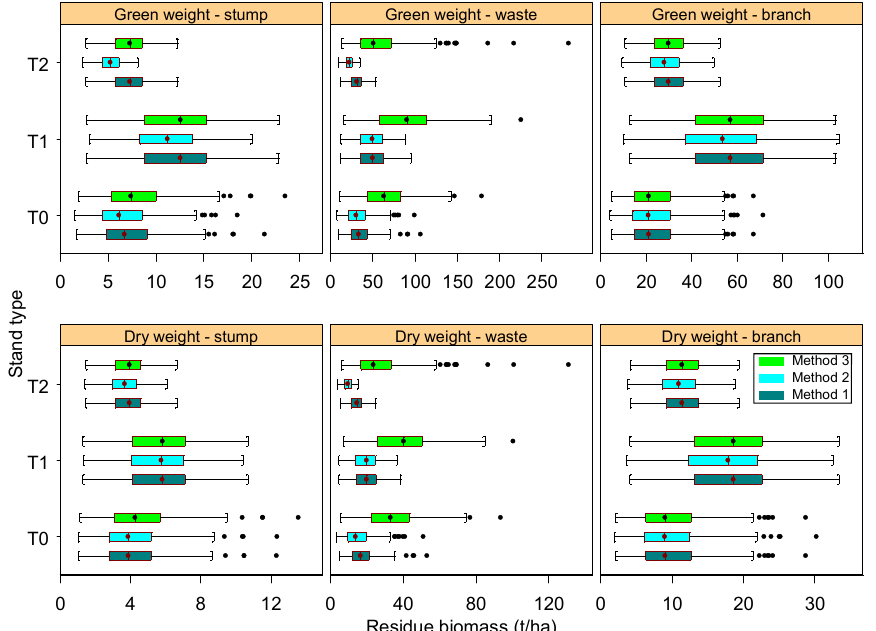
Figure 7. Boxplots of biomass estimates for three residue components in green and dry weight obtained through the three estimation methods for T0, T1, and T2 plantations.